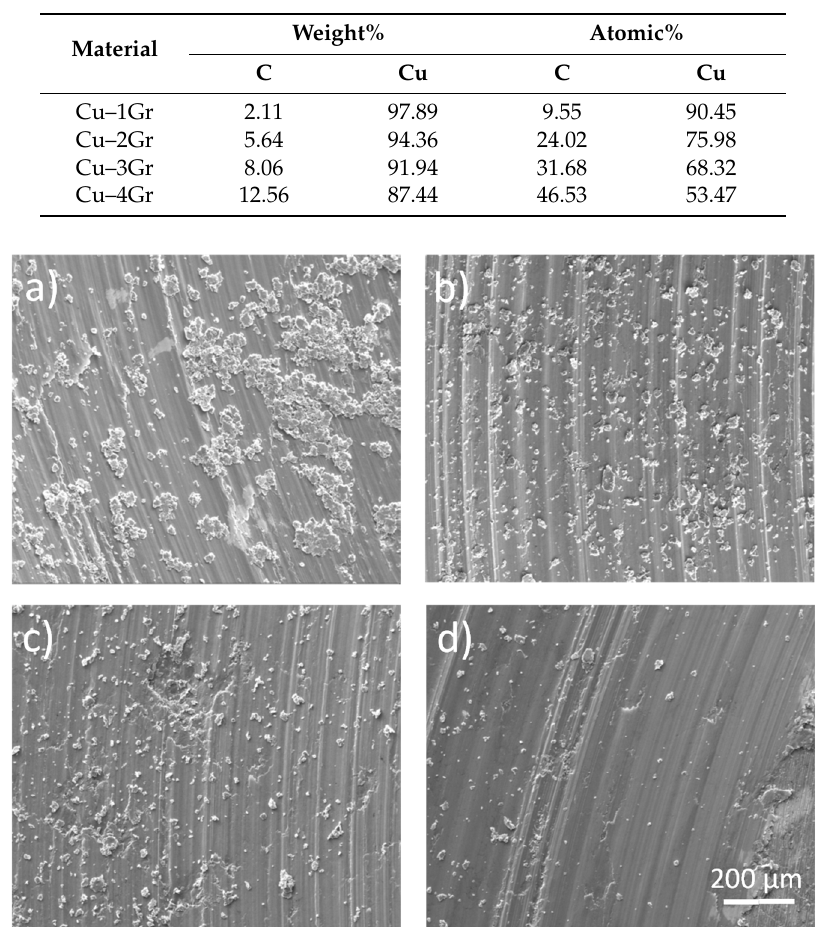
Figure 3. SEM images of the wear track of copper–graphite composites, ( a ) Cu–1Gr, ( b ) Cu–2Gr, ( c ) Cu–3Gr, and ( d )